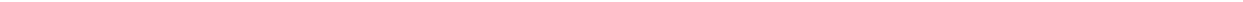
Fig. 3 Acarbose elicits stronger impact on the gut microbiota than Glipizide. Effects of Acarbose a and Glipizide b treatments on gene rarefaction, n = 51 in Acarbose pre and Acarbose post-treatment, n = 43 in Glipizide pre-treatment and Glipizide post-treatment. All bar plots are shown as mean ± S.D. The number of genes in each group was calculated after 100 random samplings with replacement. The effects of treatment in both arms on gene richness c and Shannon index d of the gut microbiome, n = 51 in Acarbose pre and Acarbose post-treatment, n = 43 in Glipizide pre and Glipizide post-treatment. e mOTUs signi fi cantly changed in abundance by Acarbose treatment (left panel), Benjamini – Hochberg q -value < 0.01, presented in box-plots to illustrate the relative abundances of the different groups. The mOTUs are listed in the order of their relative abundances pre-treatment. mOTUs in red represent mOTUs that decreased in abundance are after Acarbose treatment, whereas mOTUs that increased in abundance are given in green. The phylum colour code is indicated to the left of the mOTU annotation. The same mOTUs did not change after Glipizide treatment (right panel of e ). All plotted boxes are interquartile ranges. Dark lines in the boxes indicate medians, the lowest and highest values within 1.5 times IQR from the fi rst and third quartiles. Outliers are shown as circles beyond the whiskers. n = 51 in Acarbose, n = 43 in Glipizide, *Bi fi dobacterium catenulatum − Bpc: Bi fi dobacterium